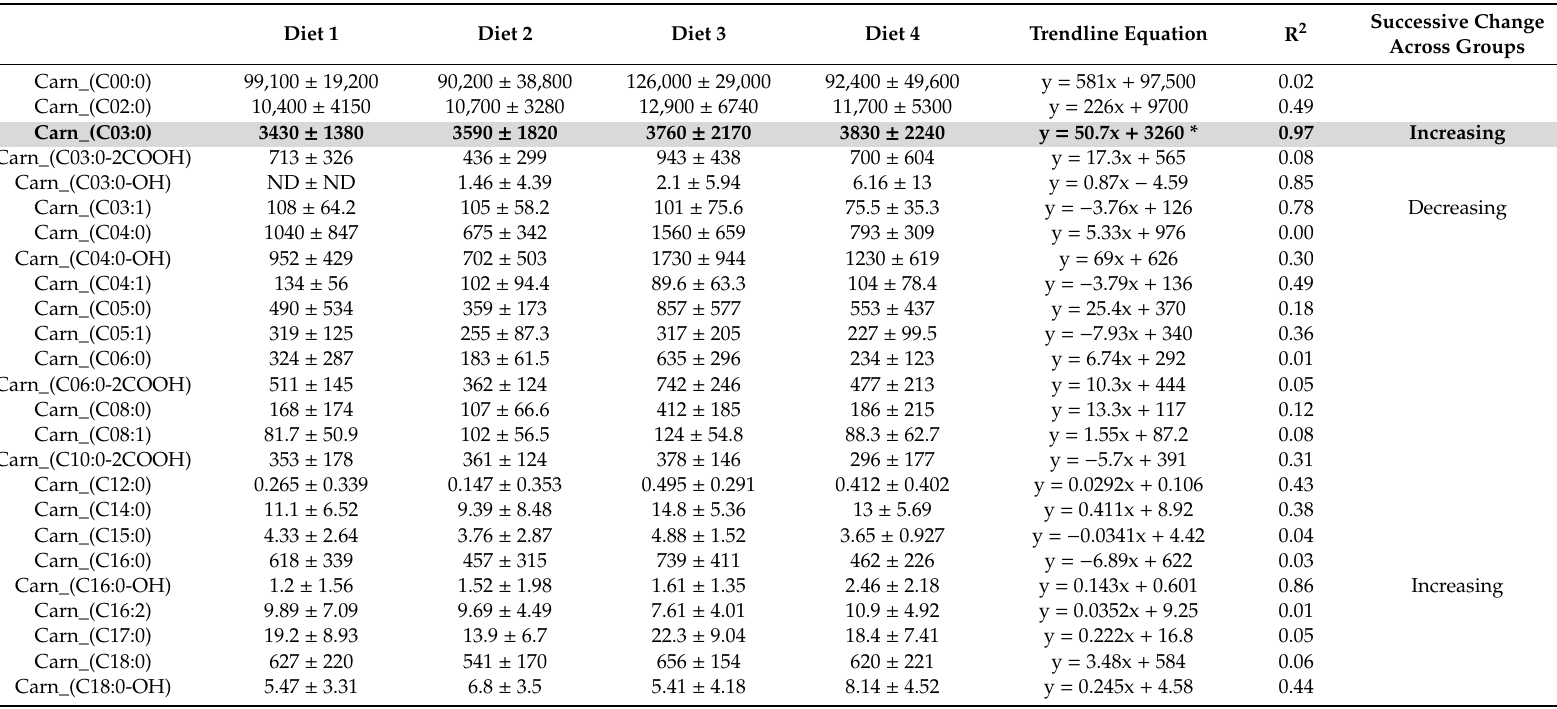
the protein precipitation liquid extraction protocol (chloroform: methanol: acetone, ~7:3:4). Correlation between the ruminant fat composition of the diet and the lipid concentration are depicted by the trendline equation (* denotes statistical significance of the slope: p -value < 0.05) and coe ffi cient of determination (R 2 ). Lipid concentrations continually increasing / decreasing across the groups as the ruminant fat composition of the diet increase are emphasised in the ‘Successive change across group’ column. Lipids with a significant slope ( p -value < 0.05) with an R 2 greater than 0.75 and successively increasing / decreasing are in bold and